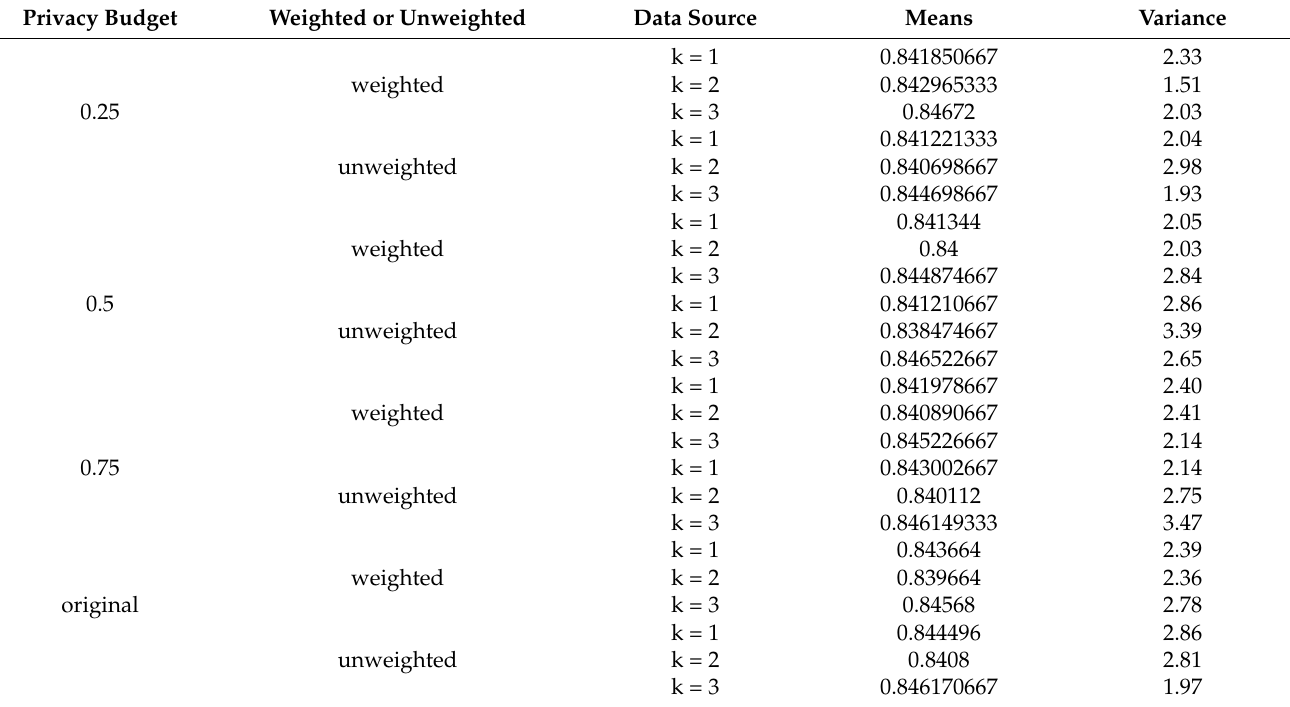
Table 3. The stacking ensemble performance of the initial global model H 1 for the t 2